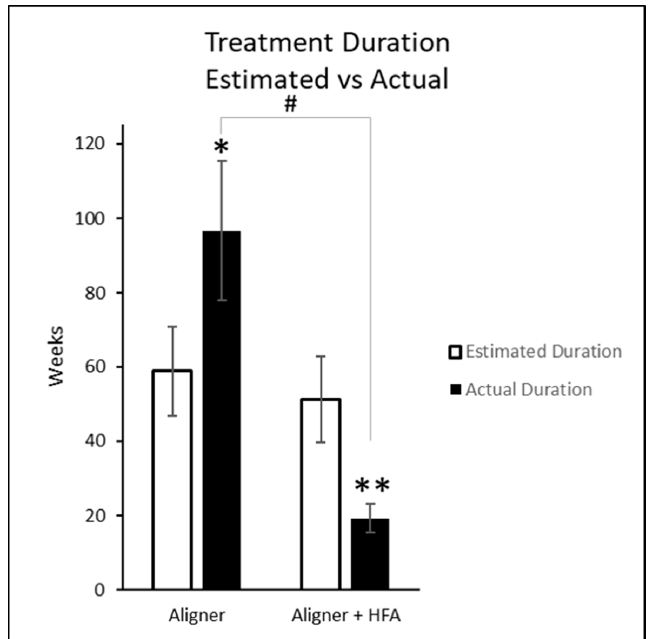
Figure 2. Estimated and actual treatment durations. * = Actual treatment duration for Aligner group significantly longer than estimated p < 0.005. ** = Actual treatment duration for Aligner + HFA significantly shorter than estimated p < 0.001. # = Actual treatment duration for Aligner + HFA group significantly shorter than Aligner group, p < 0.001.